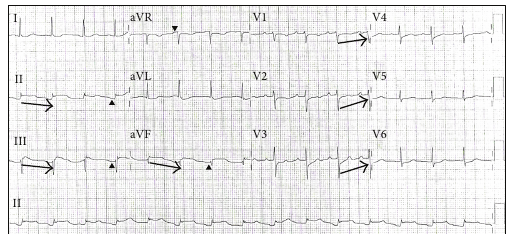
Figure 1: Initial electrocardiogram, showing inferior ST-segment elevations in II, III, and aVF with reciprocal ST-segment depressions in the anterior leads (V1–V4). Arrowheads show PR depression in the inferior leads, with corresponding PR elevation in aVR. Arrows show the downsloping ECG baseline from one QRS complex to the following PR-segment (Spodick’s sign) in the inferior leads, with corresponding upsloping ST-segment depression in the anterior leads (“reverse” Spodick’s sign).